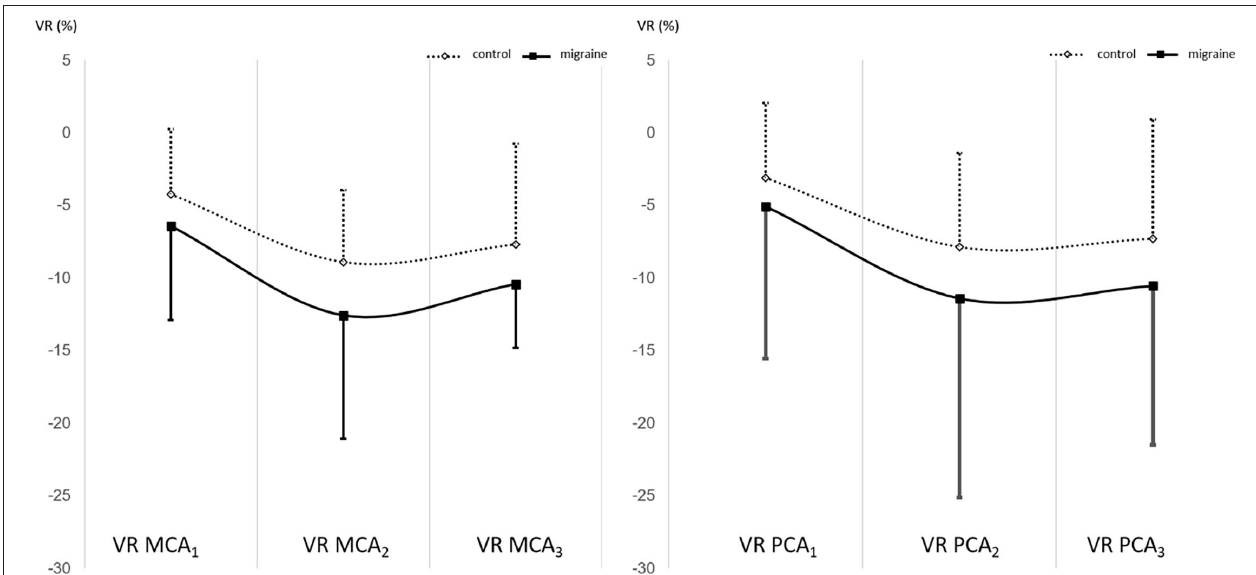
FIGURE 1 | The VR MCA for migraine and non-migraine and VR PCA for migraine and non-migraine.